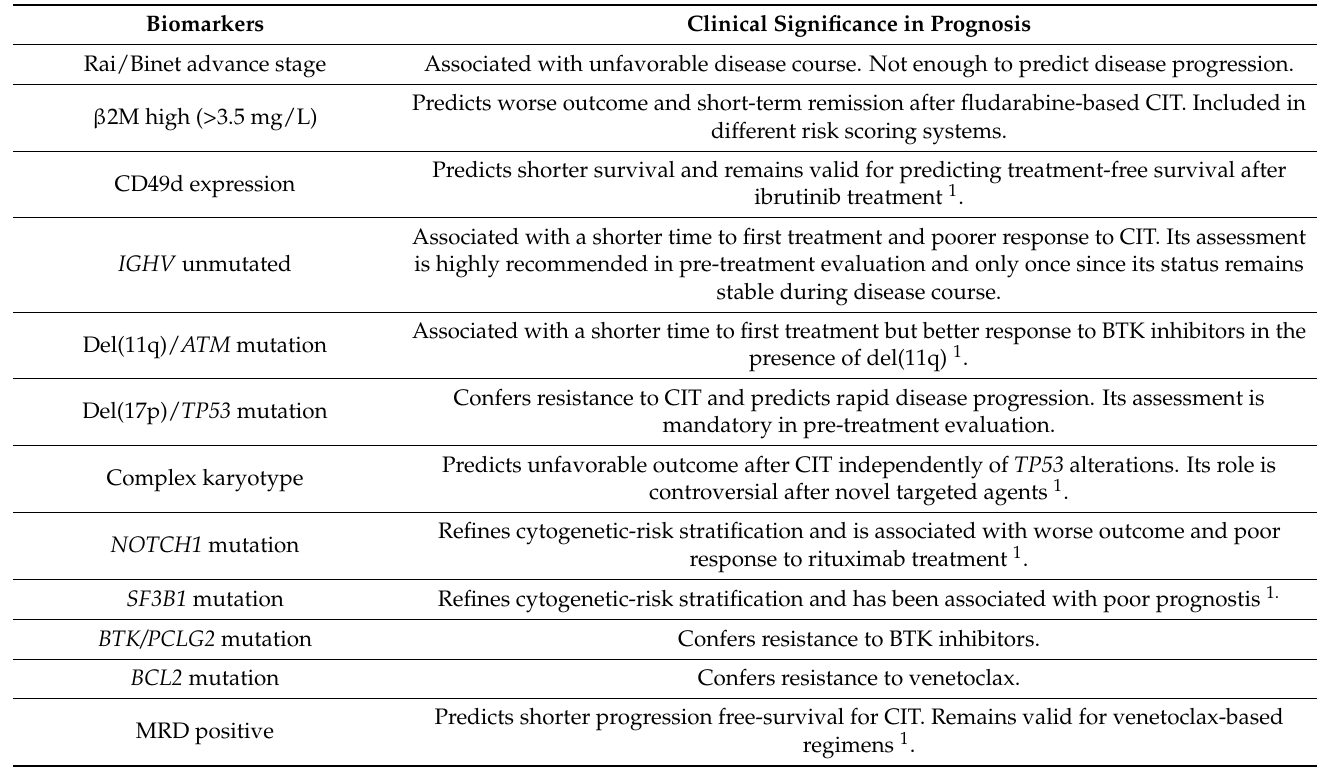
Table 1. Clinical significance of the main prognostic markers in